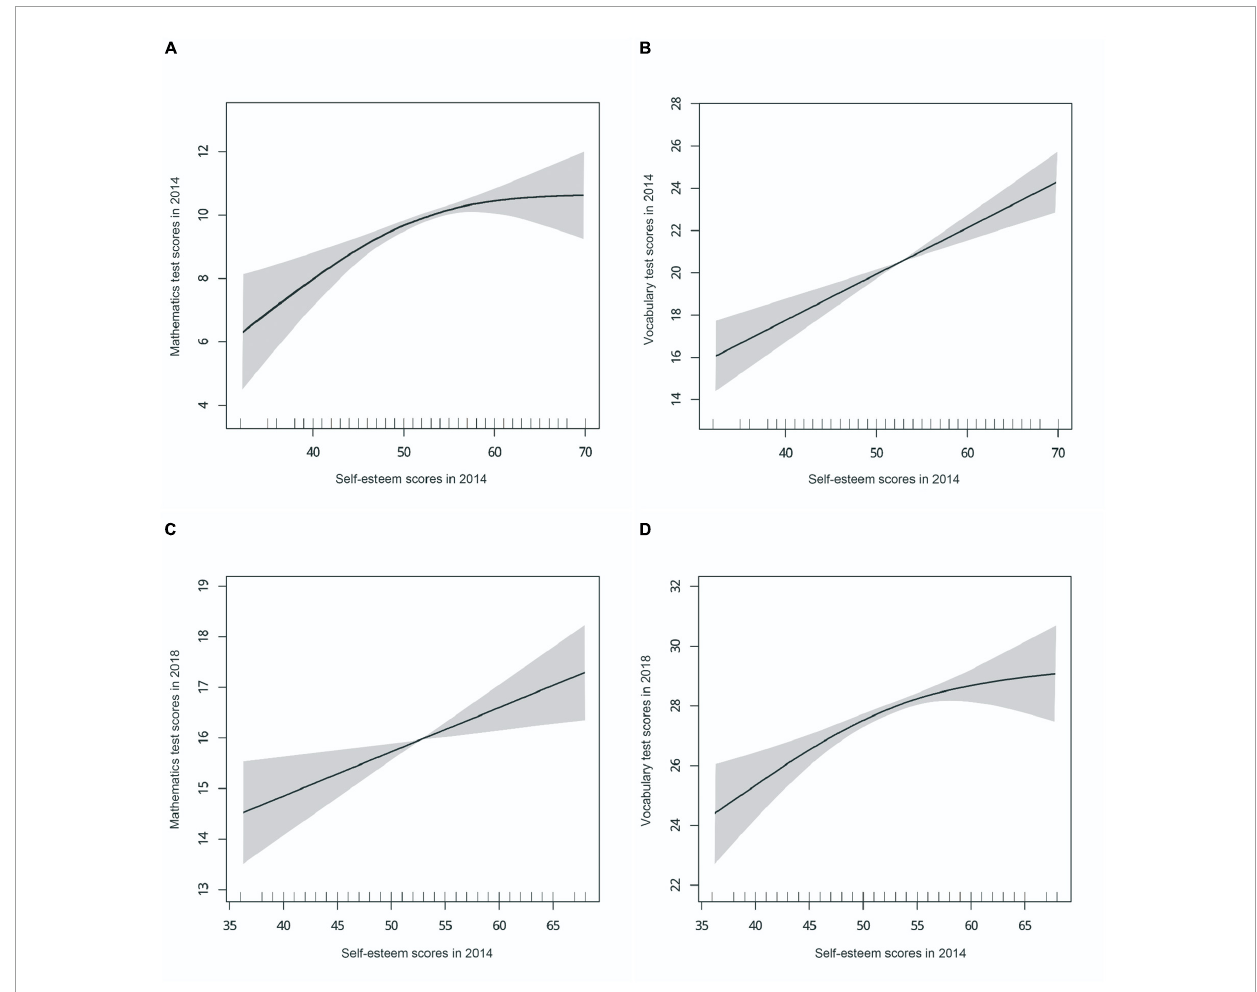
FIGURE2 The association of self-esteem in 2014 with cognitive test scores in 2014 and 2018. (A) Association of self-esteem scores in 2014 with mathematics test scores in 2014. (B) Association of self-esteem scores in 2014 with vocabulary test scores in 2014. (C) Association of self-esteem scores in 2014 with mathematics test scores in 2018. (D) Association of self-esteem scores in 2014 with vocabulary test scores in 2018. Adjusted for adolescents’ characteristics (age and gender), parents’ characteristics (maternal age, paternal age, maternal education level, paternal education level, maternal employment status, paternal employment status), and household characteristics (urban–rural location, household per capita income, family size). Solid lines represent the spline curve, and the shaded areas represent the 95% confidence interval of the spline